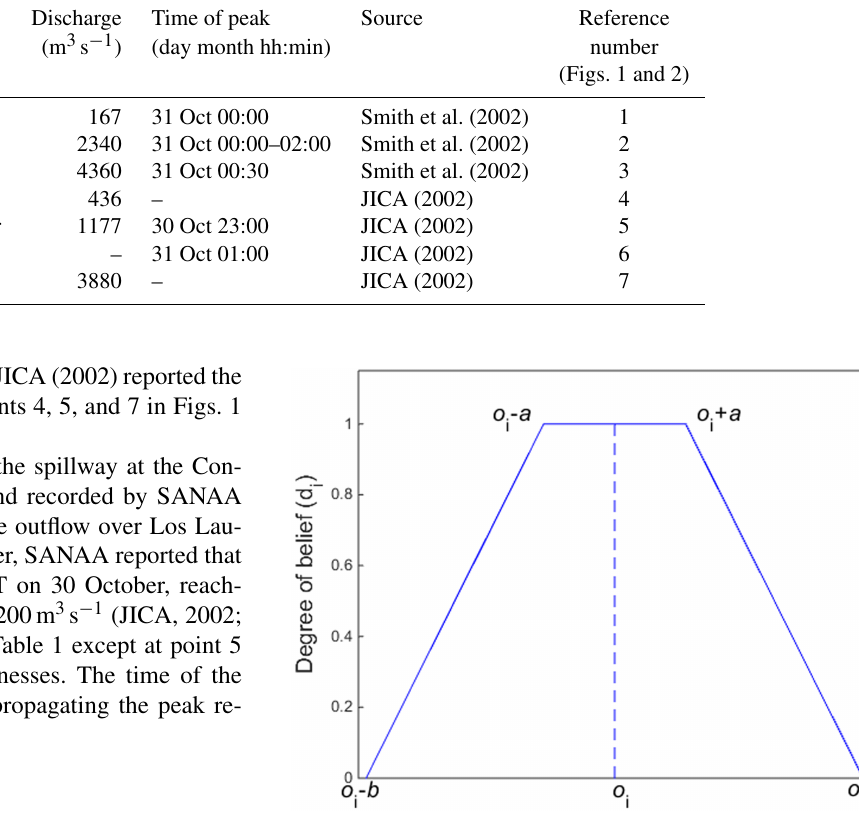
Figure 4. Fuzzy membership function for evaluation of model per- formance: a and b depend on the uncertainty associated with the evaluation ( o i